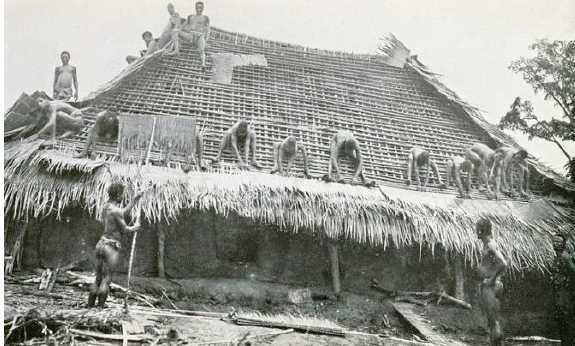
Figure 15 i. Thatching with palm leaf mats, early 20th century. Source: Basden